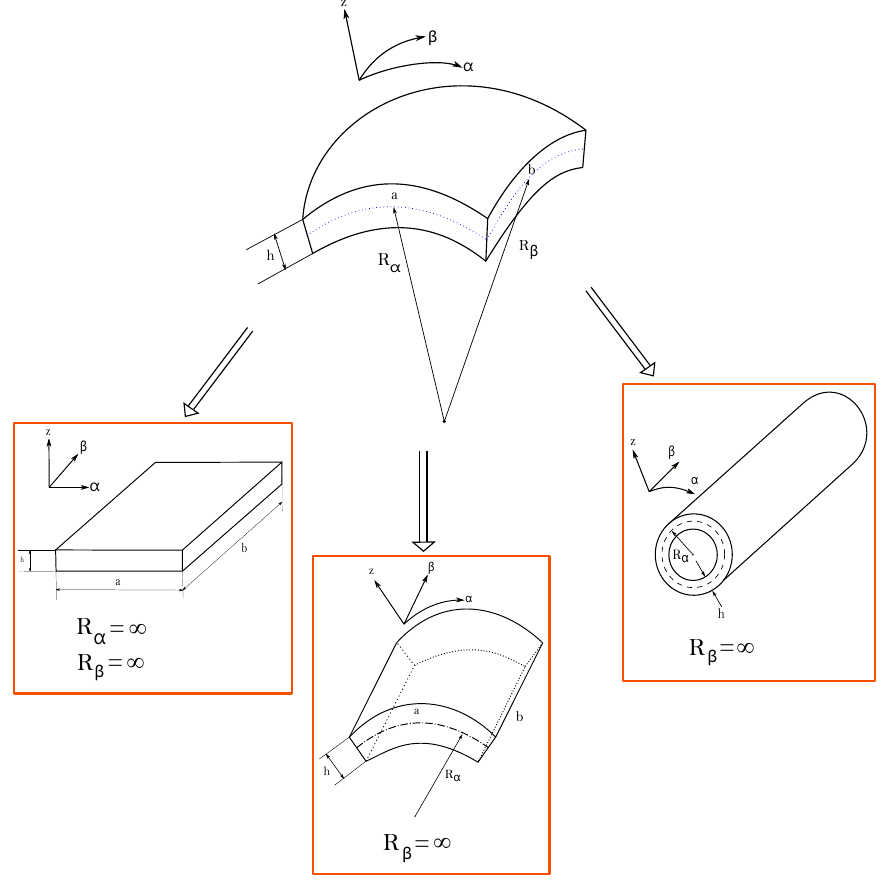
Figure 1. Geometries for assessments and benchmarks. Spherical shell and related particular cases as plate, cylindrical shell, and